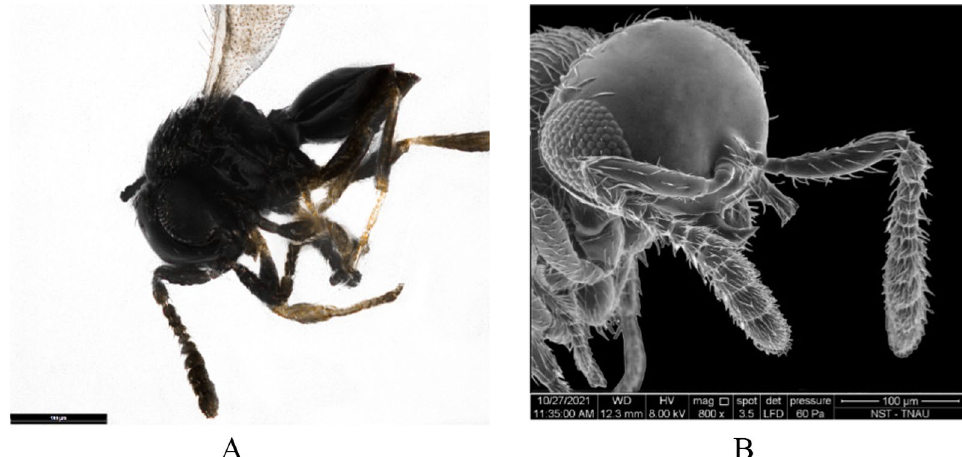
Fig. 16 A, B Club shaped antenna of female T. remus